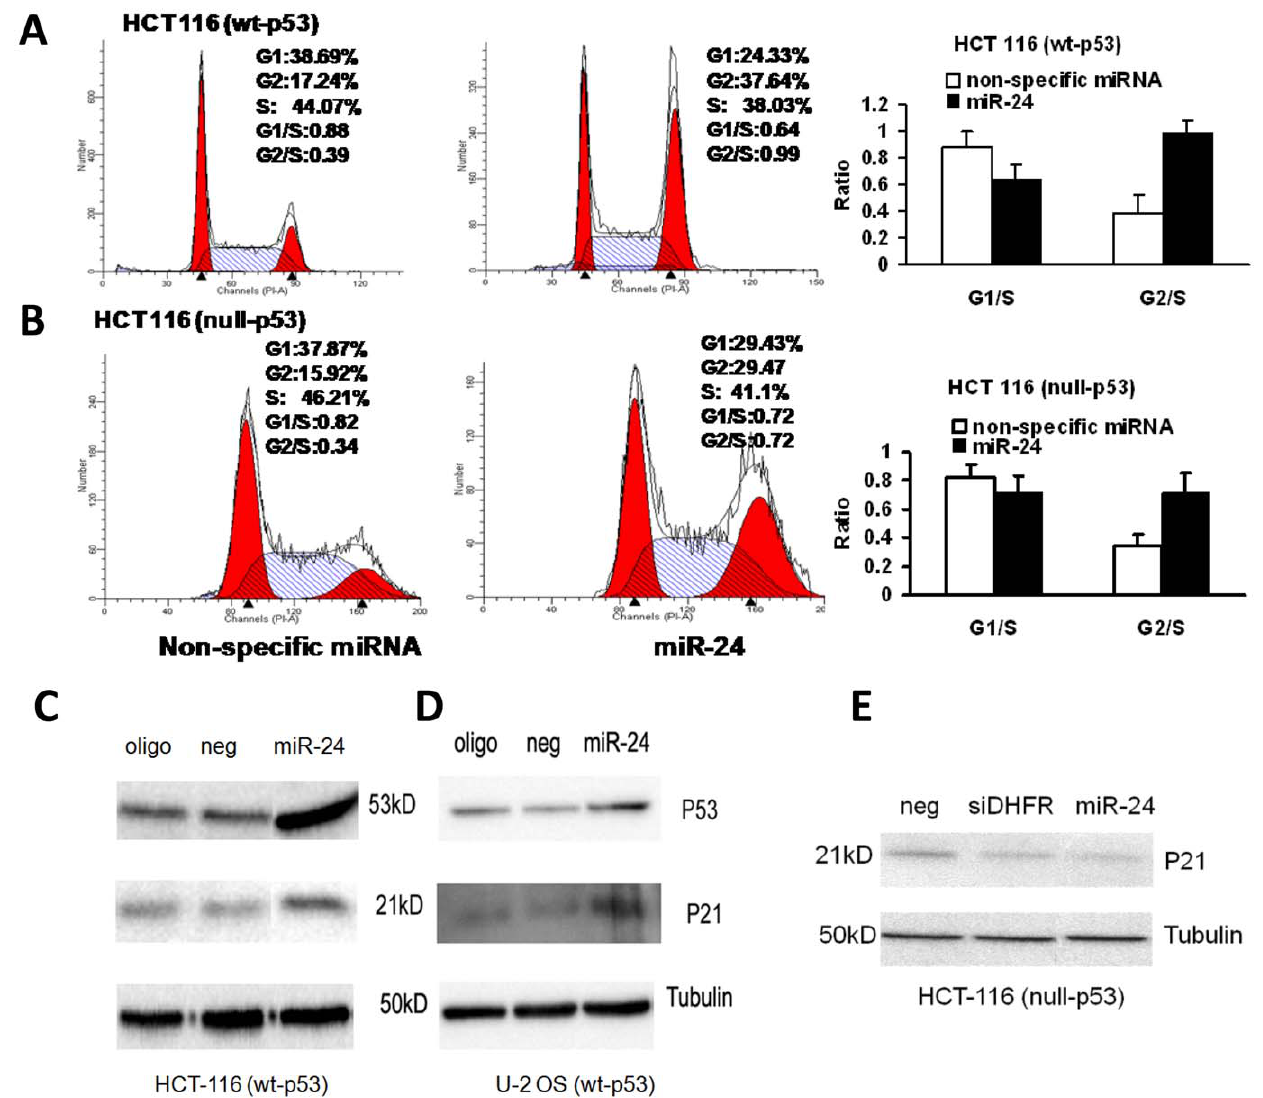
Figure 2. MiR-24 induces a p53 independent G2-cell cycle arrest. (A, B) The bar graphs show the relative quantity of G1/S and G2/S ratio between the non-specific miRNA (negative control) and miR-24 transfected cells. MiR-24 transfection induced a G2-cell cycle arrest. (C, D) miR-24 increases the expression of cell cycle control genes p53 and p21 in HCT 116 (wt-p53) and U-2 OS cells as determined by Western blotting. (E) In p53 null HCT-116 cells, independent of p21, miR-24 inhibited the G2 arrest (B and